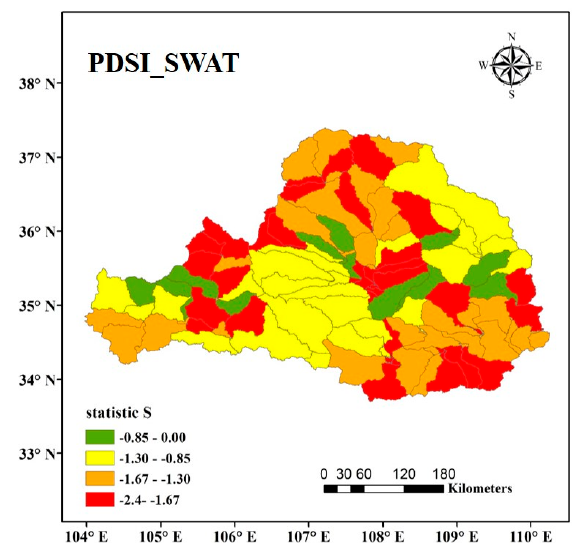
Figure 7. Spatial patterns of the statistic S in the WRB (A positive/negative of the statistic S indicates an increasing/decreasing trend of drought.)